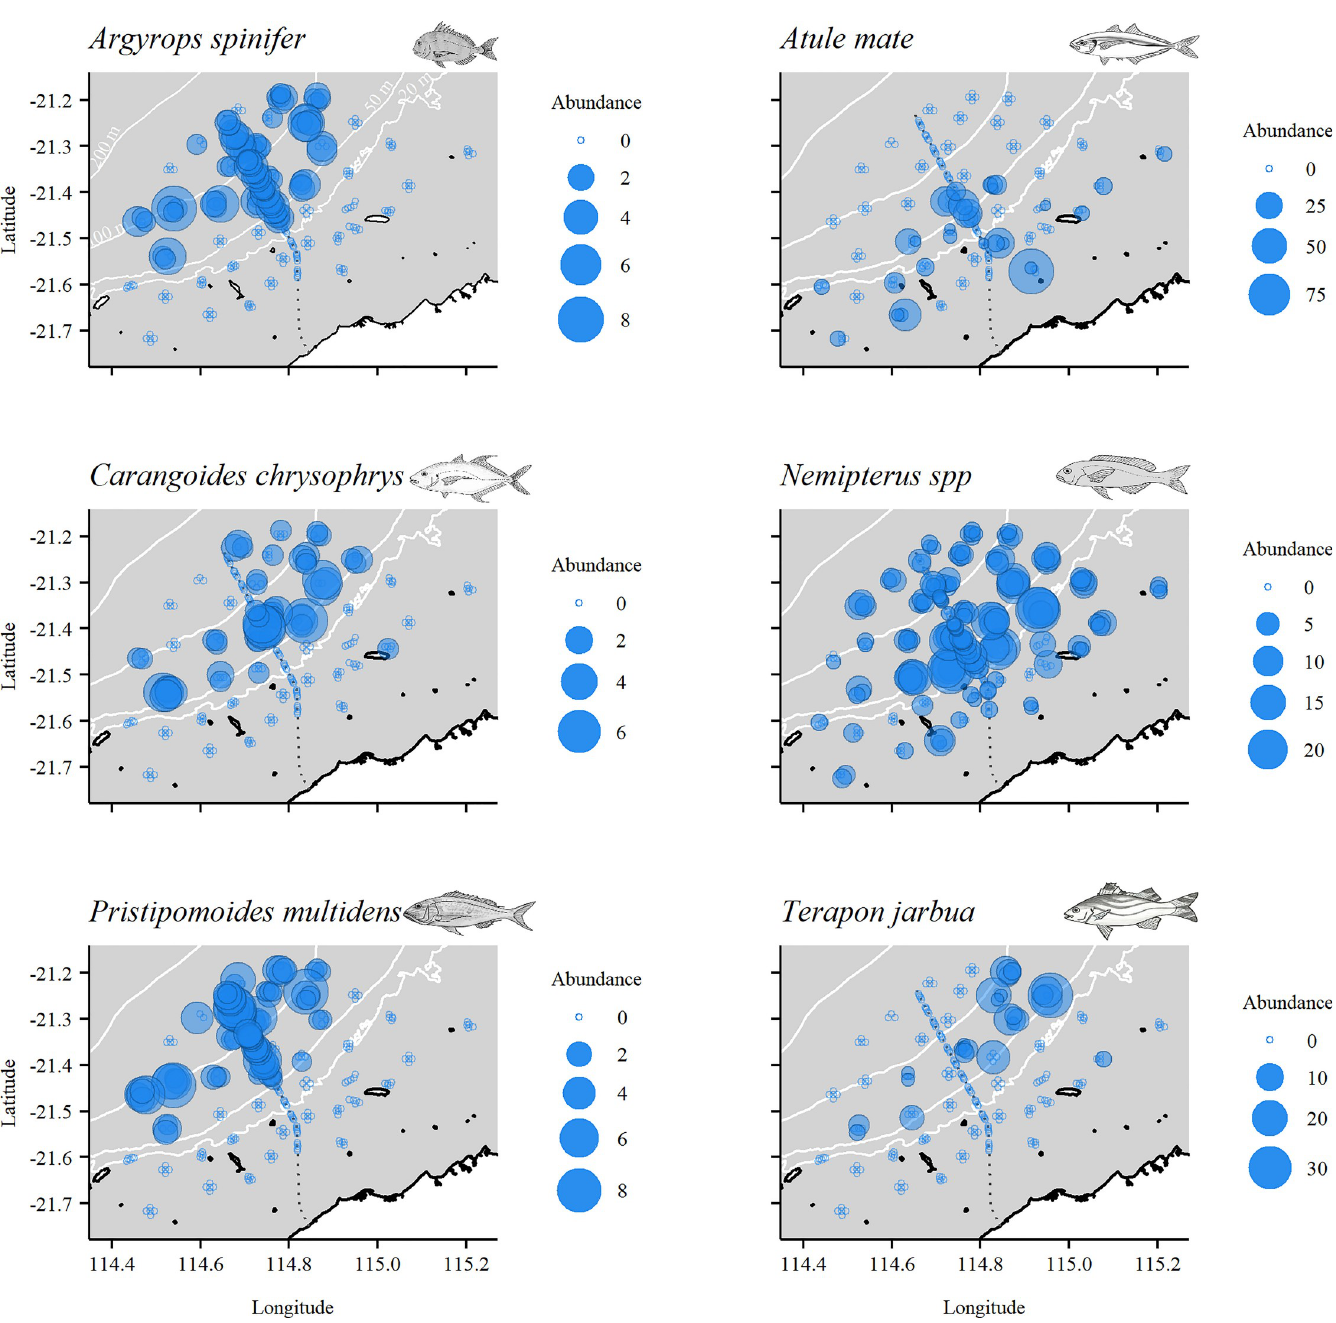
Fig 6. Spatial distribution of the relative abundance of key species on deployments in 40–80 m depth. MaxN bubble sizes reflect abundance, and therefore bubble size may be larger or smaller than those in the legend.